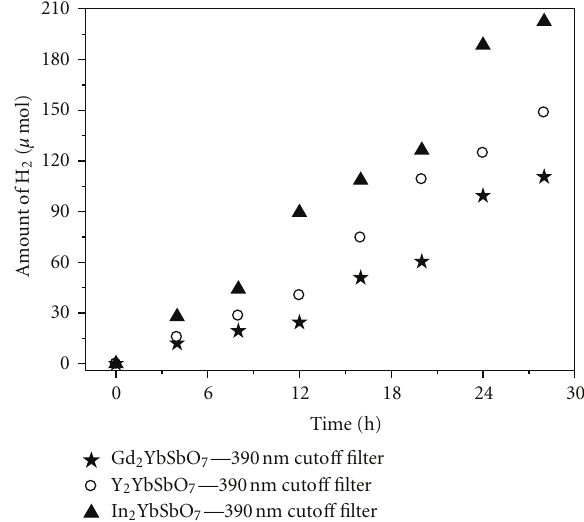
Figure 4: Photocatalytic O 2 evolution from AgNO 3 solution with Y 2 YbSbO 7 , In 2 YbSbO 7 , or Gd 2 YbSbO 7 as catalyst under visible light irradiation ( λ > 420nm, 0.5g photocatalyst, 1mmol AgNO 3 , 270mL pure water). Light source: 300 W Xe lamp.